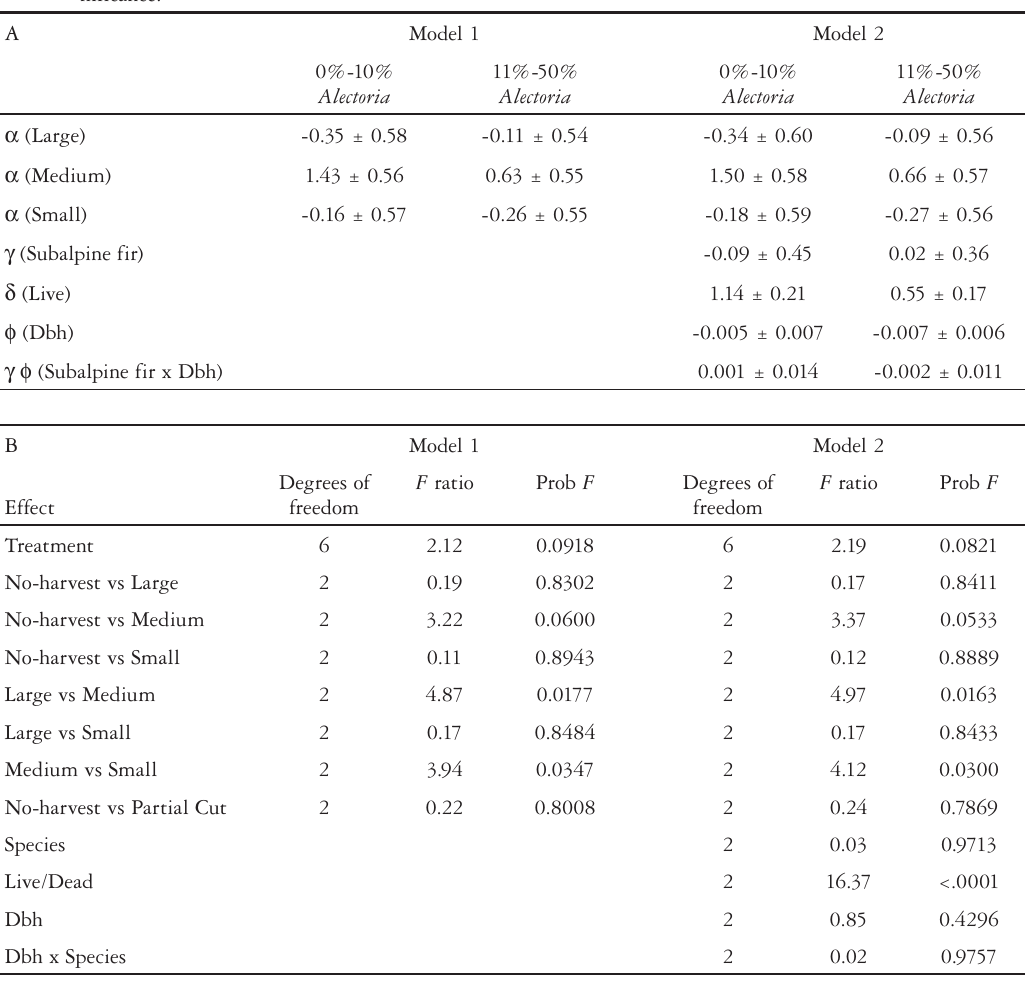
Table 2. Logistic regression models of lichen composition (% Alectoria ) immediately post-harvest (1993). The reference value in the analysis is Alectoria > 50%. A) Parameter estimates ( ± estimated standard error). B) Tests of sig- nificance.